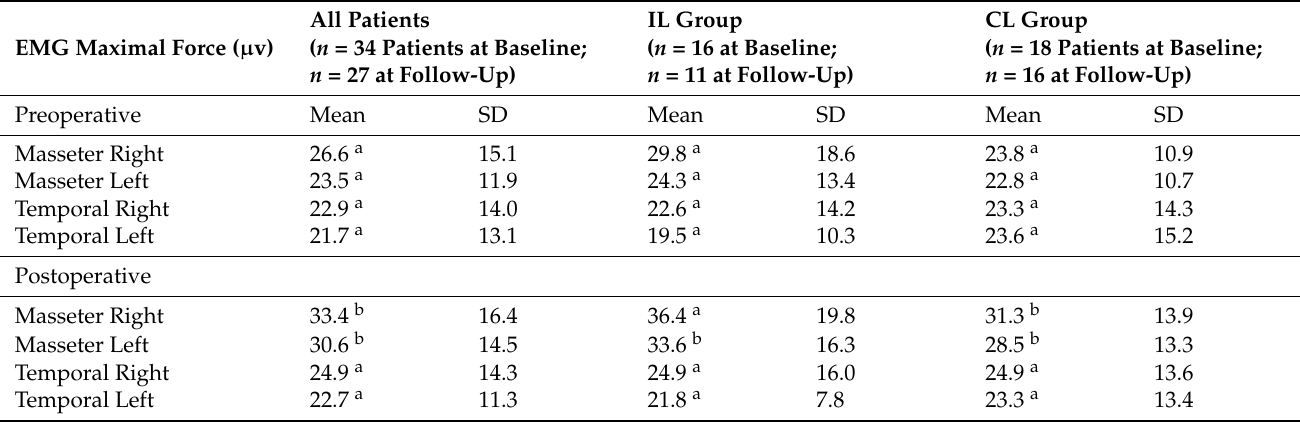
Table 5. Changes in the muscular electromyographic records ( µ v) after PEEK-Hybrid prosthetic treatments ( n = 34 at baseline; n = 27 at follow-up).